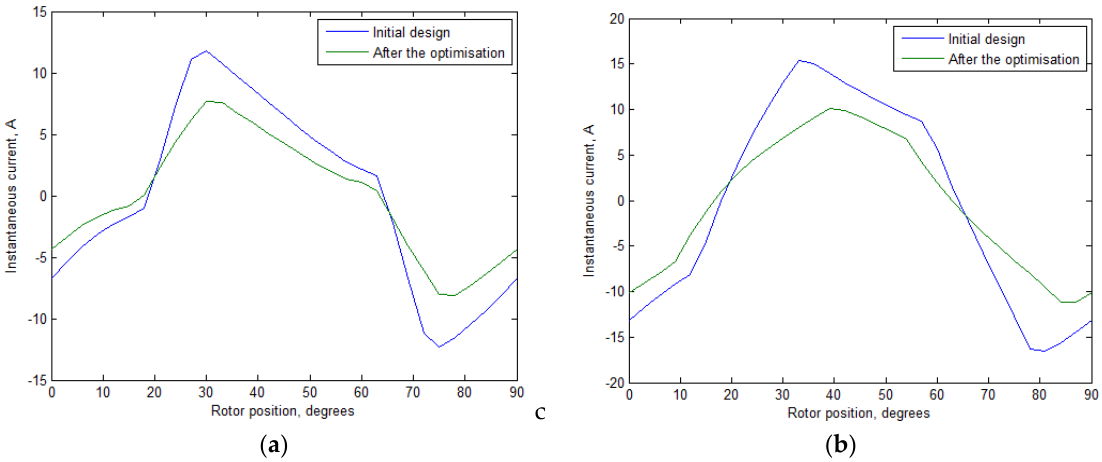
Figure 3. Torque waveforms versus the rotor angular position before and after the optimization: ( a ) mode 1; ( b ) mode 2.